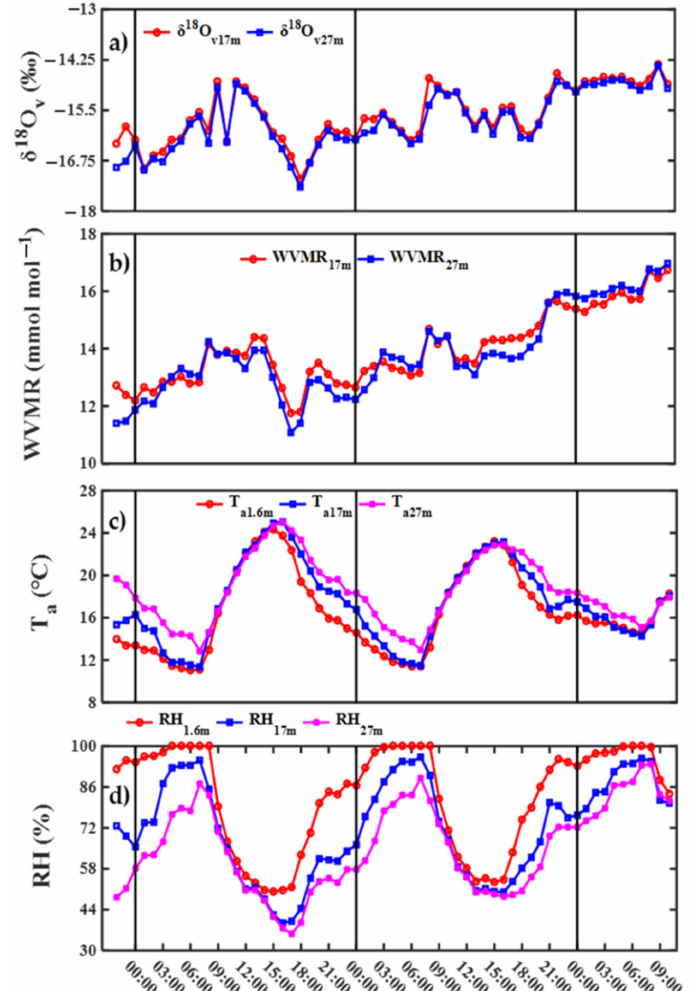
Figure 5. Diurnal variability in ( a ) water vapor δ 18 O at 17 m ( δ 18 O v17m ) and 27 m ( δ 18 O v27m ), ( b ) water vapor mixing ratio at 17 m (WVMR 17m ) and 27 m (WVMR 27m ), ( c ) air temperature at 1.6 m (T a1.6m ), 17 m (T a17m ), and 27 m (T a27m ), and ( d ) relative humidity at 1.6 m (RH 1.6m ), 17 m (RH 17m ), and 27 m (RH 27m